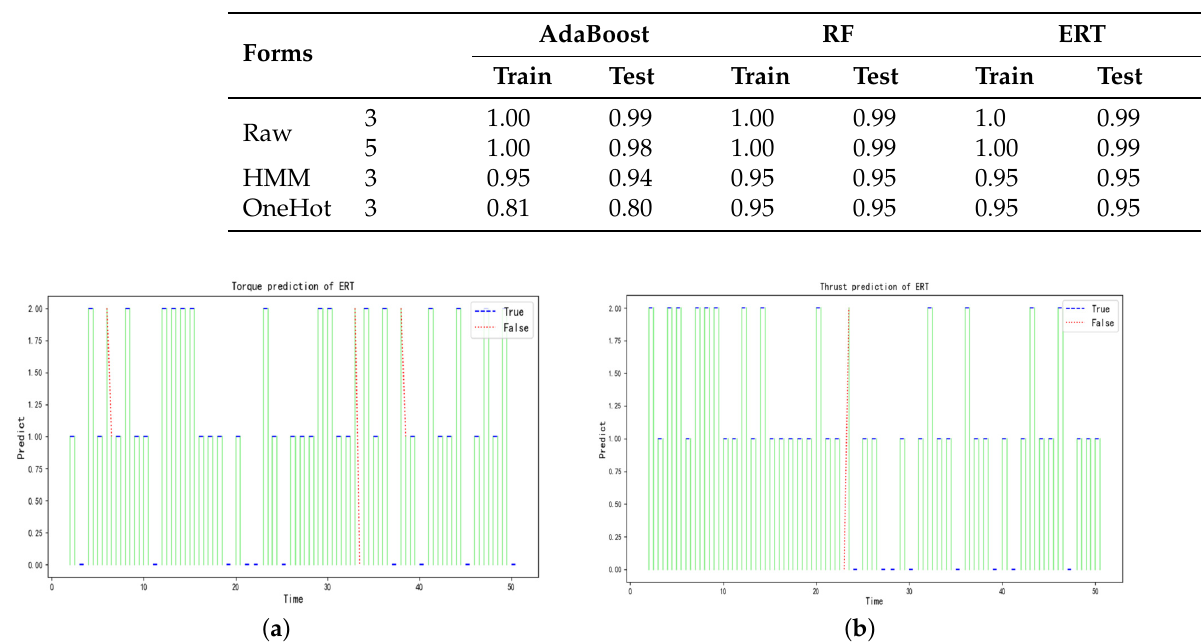
Figure 9. Comparisons between actual and predicted states of the ERT model under N s = 3: ( a ) Torque; ( b )